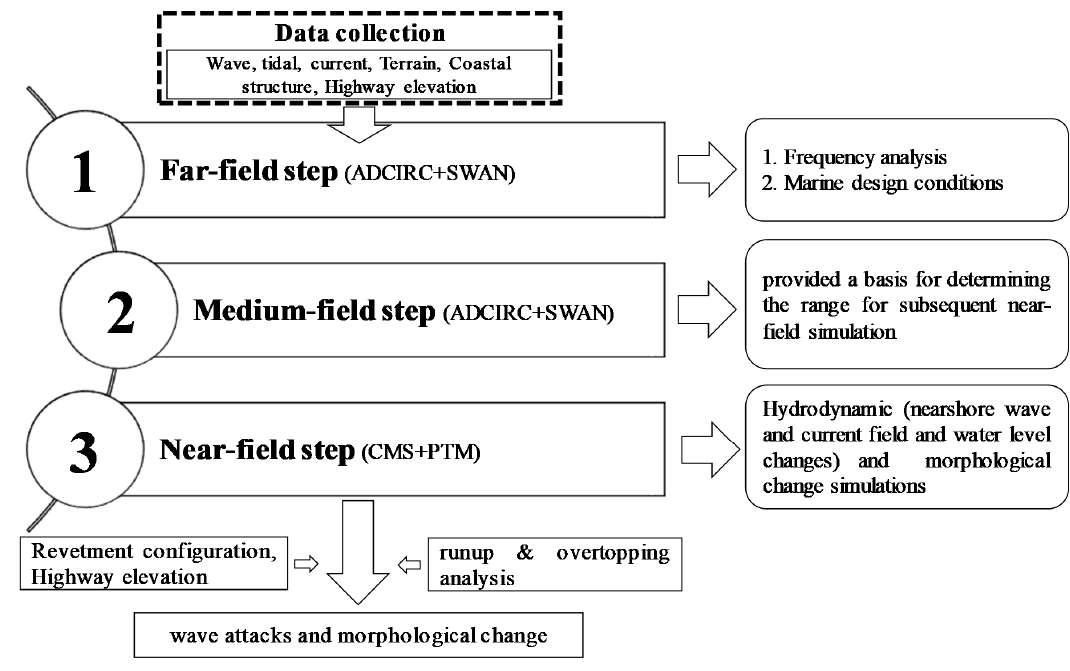
Figure 2. Schematic of the nested numerical modelling process and relevant operations.